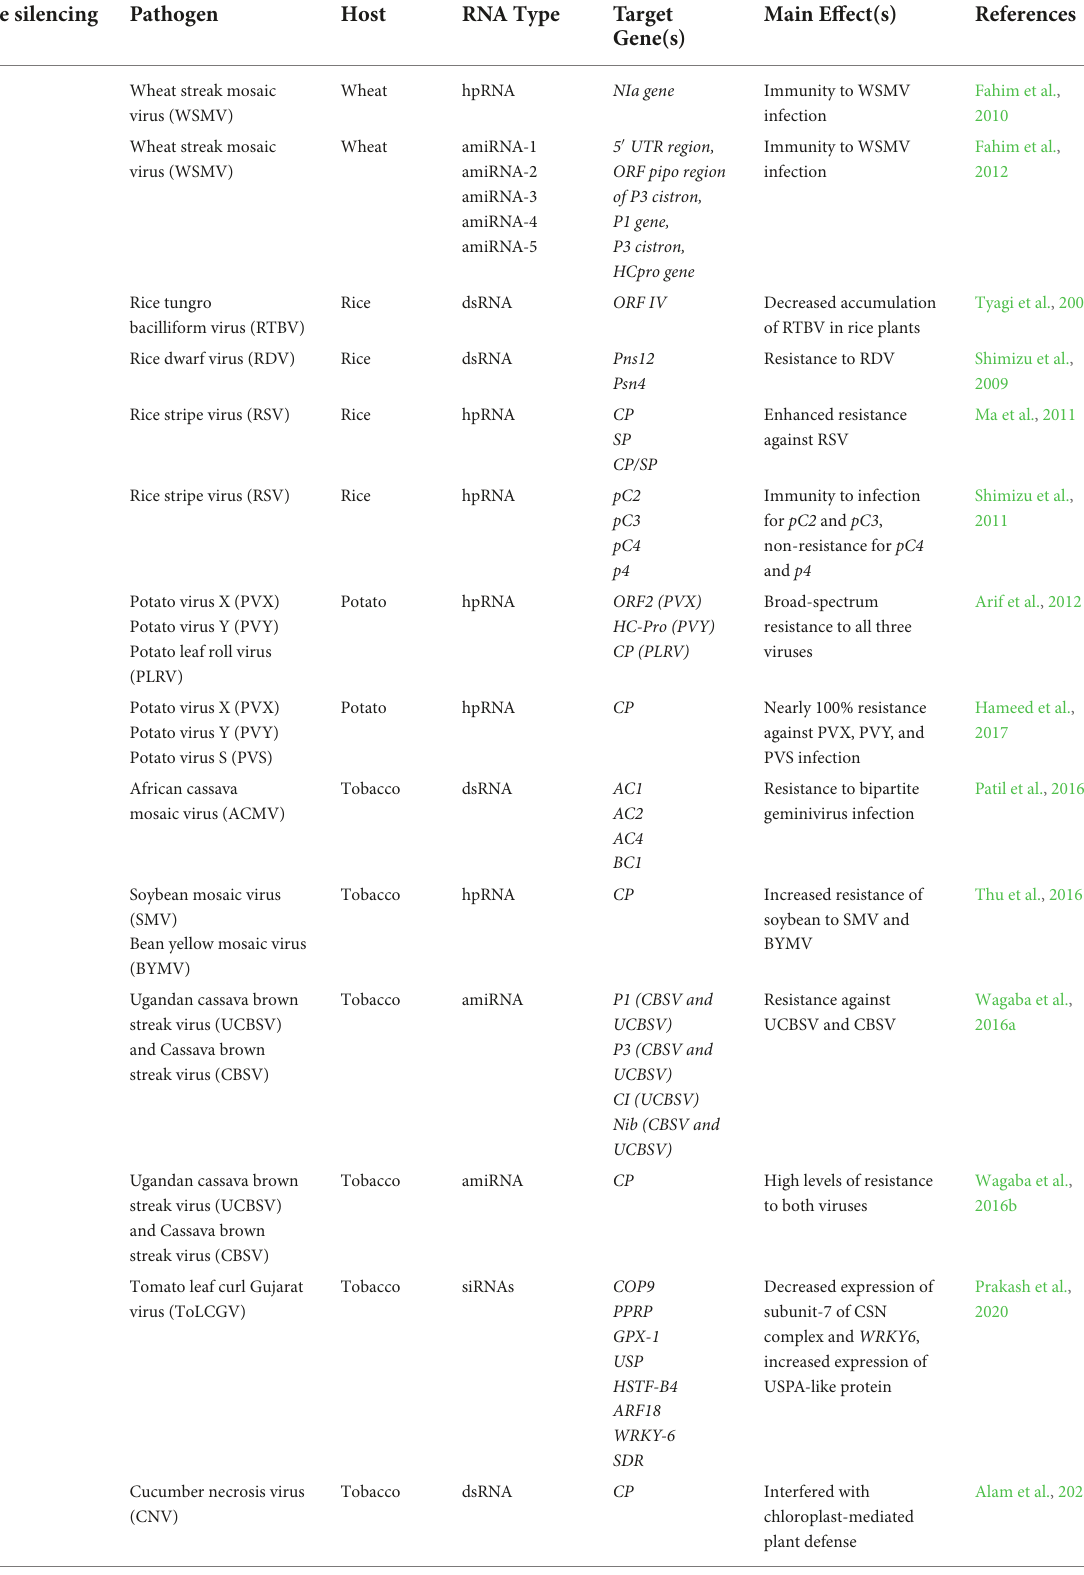
TABLE 1 Summary of HIGS and SIGS applications for control of viral